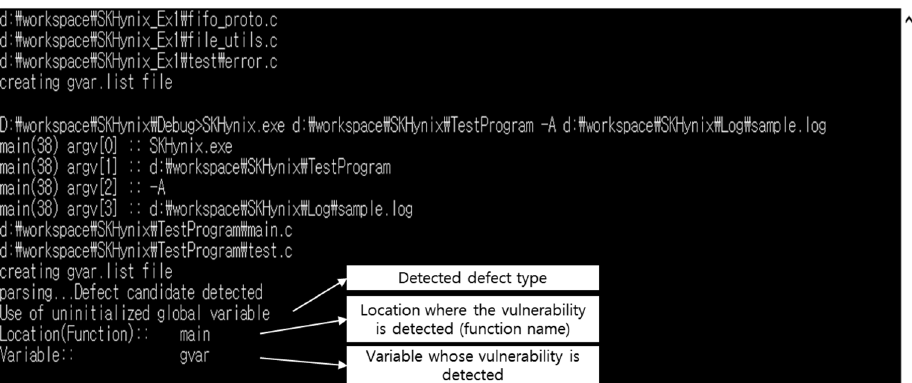
Figure 10. Results of variable vulnerability detection.